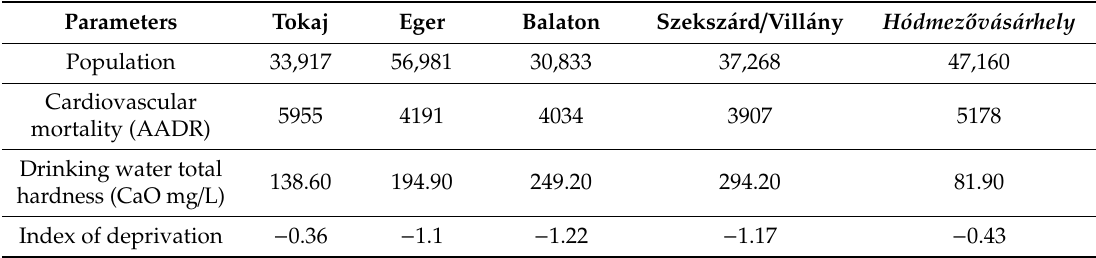
Table 1. The number of populations, age-adjusted death rates due to cardiovascular diseases, the hardness of drinking water and index of deprivation in the five regions between 2000 and